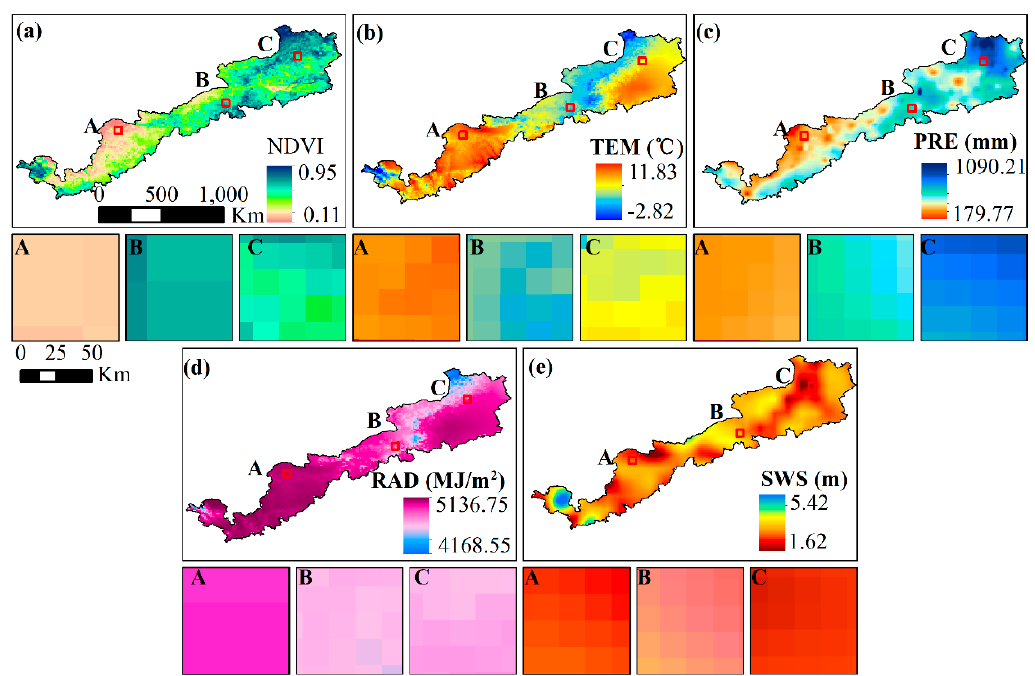
Figure 2. Distribution of the Global Inventory Modeling and Mapping Studies (GIMMS NDVI3g) product ( a ) and China Meteorological Forcing Dataset (CMFD) climate data samples (temperature (TEM), precipitation (PRE), total downward solar radiation (RAD), and near-surface wind speed (SWS)) ( b – e ). The magnified figures below each index represent the three corresponding random regions, named A, B, and C from the west to the east.